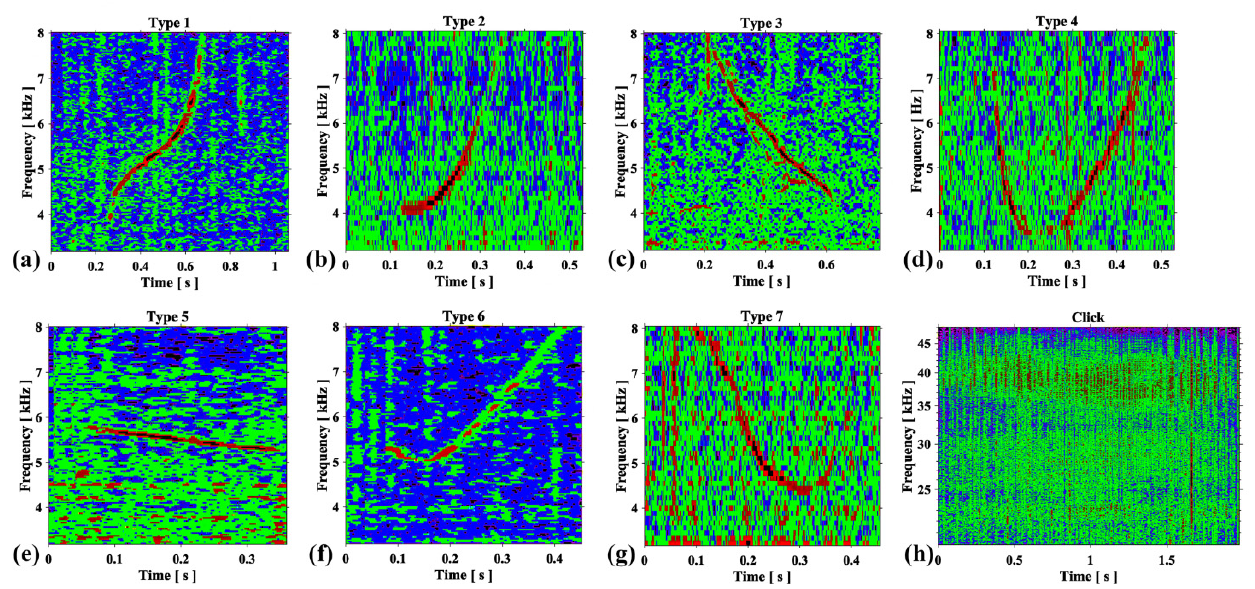
Figure 1. Spectrograms of whistle types ( a – g ) and click trains ( h ) produced by Taiwanese humpback dolphins in their natural habitat during the recording period.